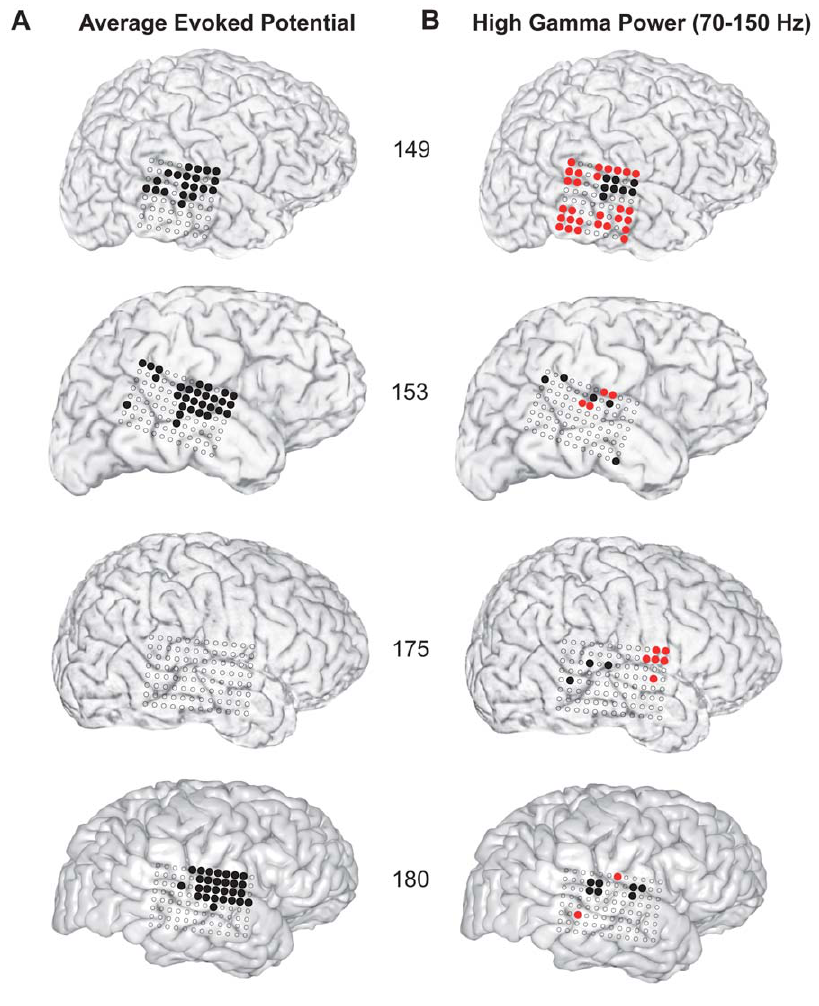
Figure 8. Composite analysis of right-sided subjects. Lateral hemispheric surface renderings of right-sided subjects (n=4) showing recording sites where responses were significantly different for the SV versus PB conditions (filled circles) during the first 250 ms following stimulus onset. In three of the four subjects shown, a large number of STG contacts showed a statistically significant decrease in AEP responses during SV (panel A, filled black circles), and there were no sites where responses were increased during SV. Sites showing statistically significant differences in HGB power responses for the two conditions are shown in panel B (filled circles). In all four subjects STG sites were identified where HGB power decreased significantly during SV (filled black circles, panel B). With the exception of subject 175, a smaller number of recording sites show a significant reduction in HGB power compared to the number of sites showing reductions in AEP responses. In all right hemisphere subjects, sites were identified where significant increases in HGB power occurred during SV (red circles). These sites were observed in different STG and non-STG locations that did not conform to a consistent anatomical pattern across subjects.